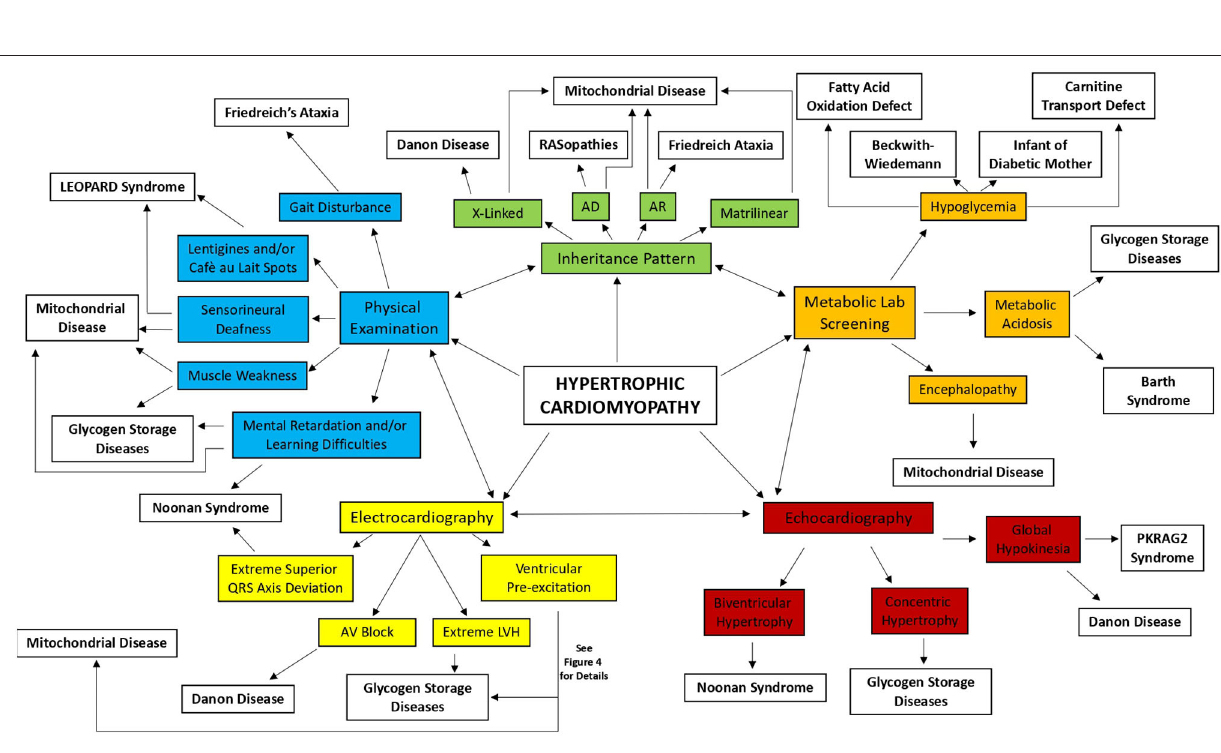
Frontiers in Pediatrics |